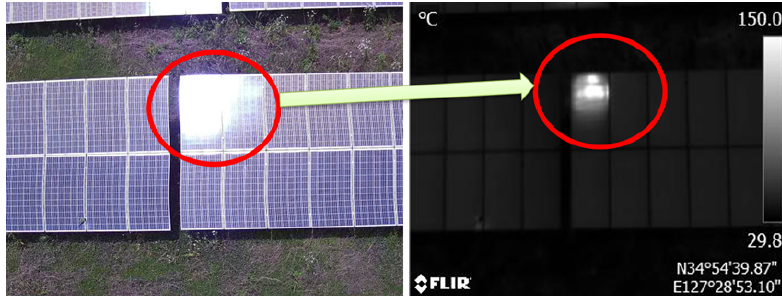
Figure 13. Hotspots caused by weed shadows: 80.2 °C.